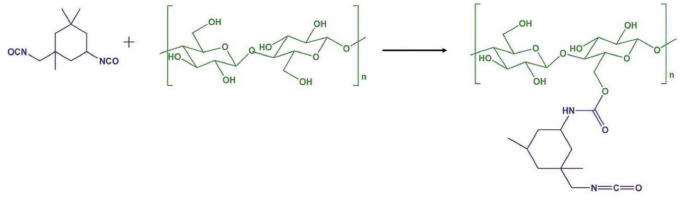
The reaction of the DP and the epoxy (E)/hardener [26].